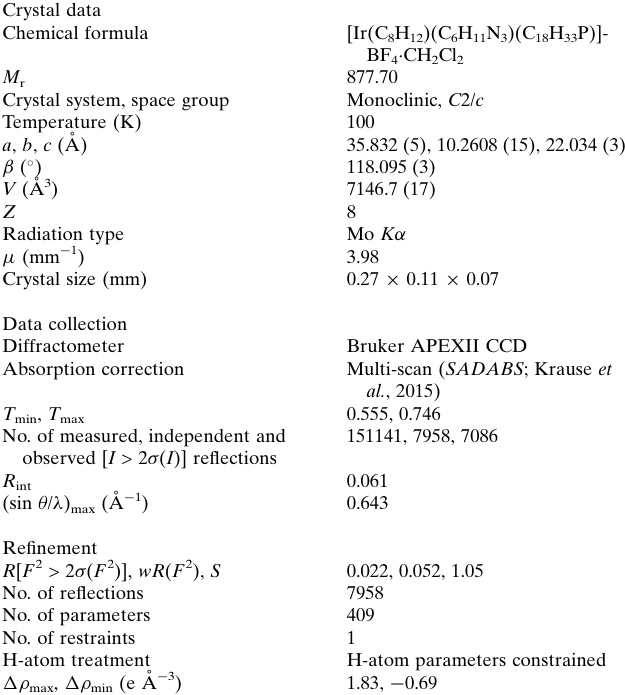
Crystal data Chemical